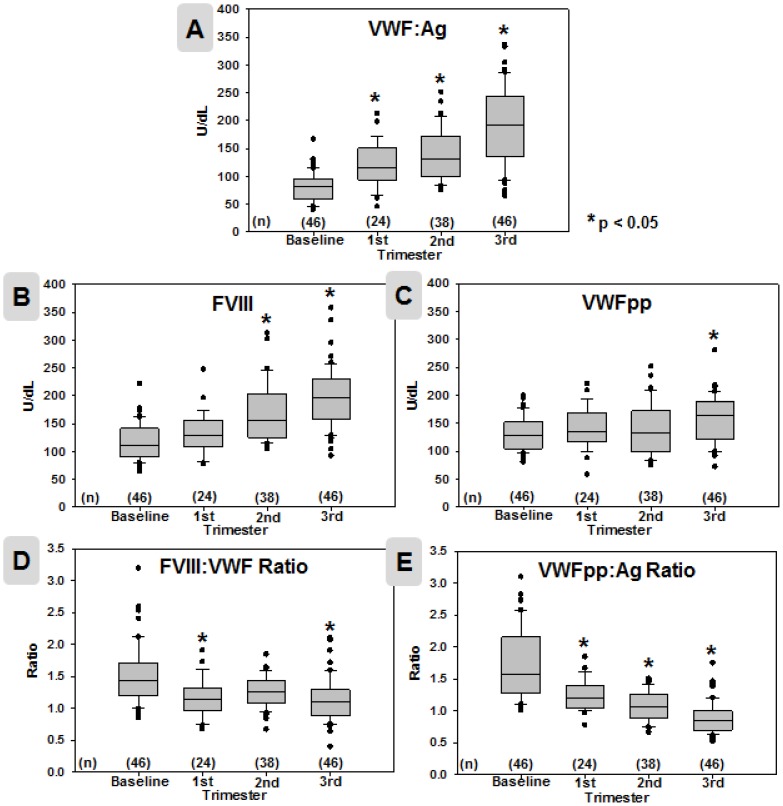
VWF-associated parameter data in 46 pregnancies.Values for VWF:Ag (A), FVIII (B), VWFpp (C), FVIII:VWF Ratio (D), VWFpp:Ag Ratio (E) are presented at each time point (non-pregnant baseline n = 46, 1st trimester n = 24, 2nd trimester n = 38, 3rd trimester n = 46). The median, 25th and 75th percentiles (boxed), 1 SD (bars), and individual outlying data points (black dots) are shown for each parameter at each time point. Statistically significant differences from baseline (p<0.05 by one-way ANOVA followed by all pairwise multiple comparisons) are indicated by asterisks (*). Values can be found in Table 2.